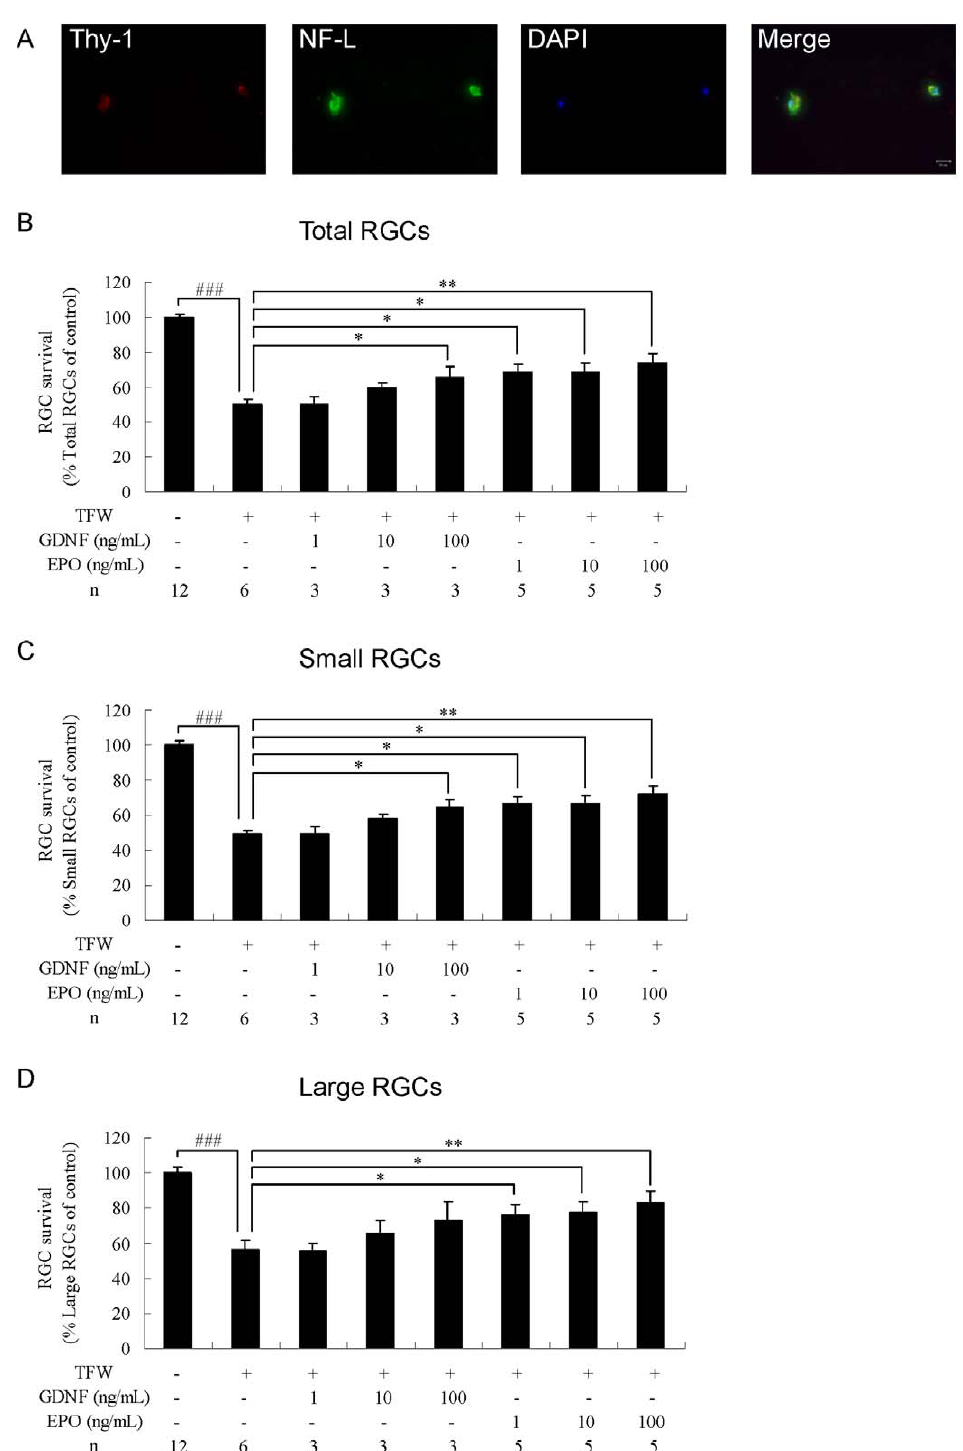
Figure 3. Effects of erythropoietin on total, small, and large RGCs under TFW-induced toxicity. (A) Morphology of TFW-treated RGCs. The cells were cultured in a medium lacking BDNF, CNTF, and bFGF. After culturing, RGCs were immunostained with anti-Thy-1 antibody (red), anti-NF-L antibody (green), and DAPI nuclear staining (blue). Survival rate of (B) total, (C) small, and (D) large RGCs. The cells were cultured in a standard medium, TFW medium, TFW medium + GDNF (1–100 ng/mL), or TFW medium + EPO (1–100 ng/mL). The number of RGCs was counted and normalized versus the control group. Data are presented as mean 6 standard error of the mean (n=3–12). # P , 0.05, ## P , 0.01, and ### P , 0.001 versus the control group according to Student’s t -test. *P , 0.05, **P , 0.01 and ***P , 0.001 versus the TFW group according to 1-way ANOVA, followed by Dunnett’s test.